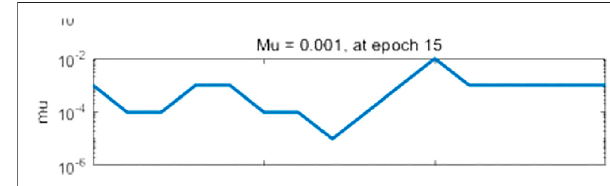
FIGURE 2 | Mu value of BP network training.